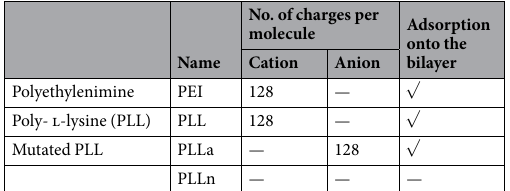
Table 2. List of